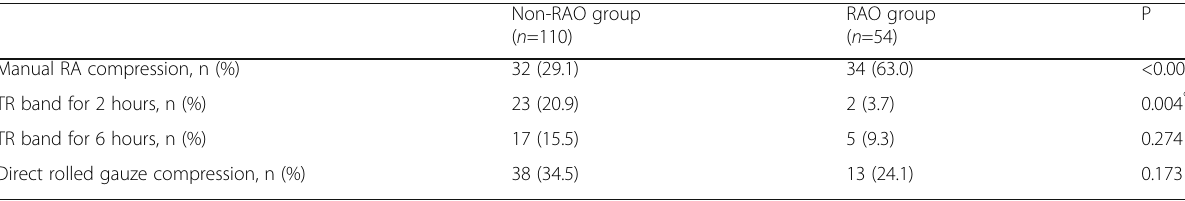
Table 4 Method of hemostasis used for the study groups